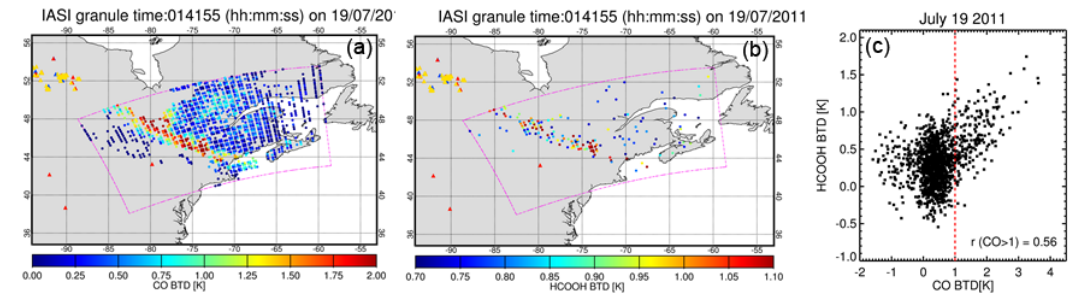
Fig. 10. Brightness temperature difference (BTD, K) detection of (a) CO and (b) formic acid (HCOOH) enhancements from a single IASI data granule for 19 July 2011. MODIS fire count data are shown as triangles according to detection certainty: high (red), nominal (yellow), and low (blue) confidence. (c) The corresponding scatter plot of CO and HCOOH with the Pearson correlation coefficient r shown inset.